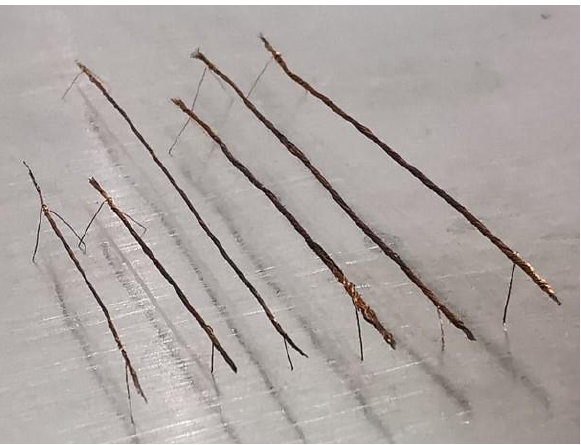
Micromachines 2021 , 12 , x Figure 15. Different masses of manufactured beam-shaped copper wire weights. Figure 15. Different masses of manufactured beam-shaped copper wire weights.